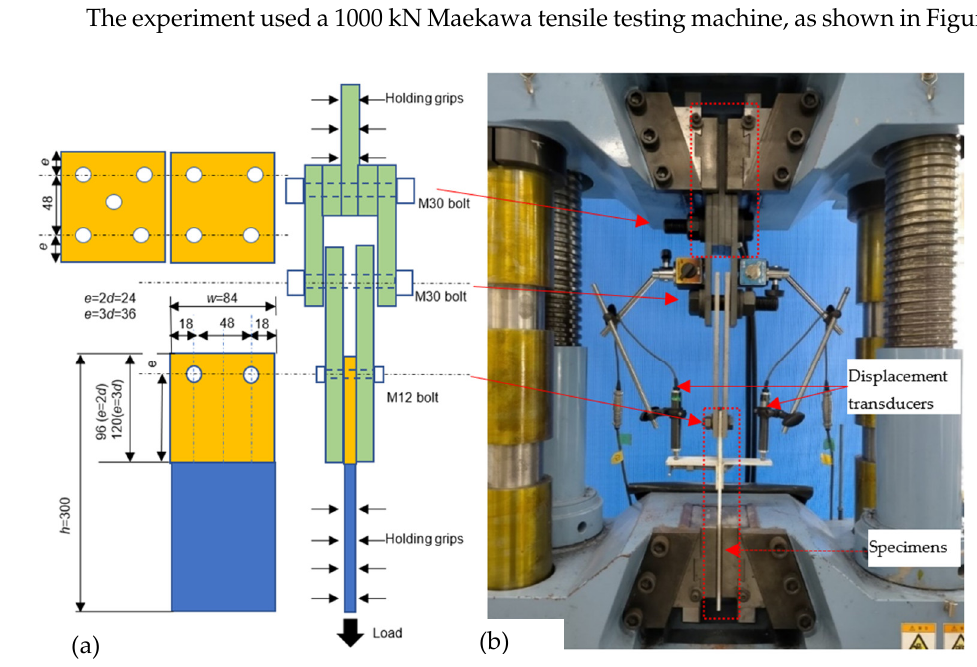
Figure 5. ( a ) Specimen configuration with five full bolts, and ( b ) test setup in tensile tests. Unit: mm.